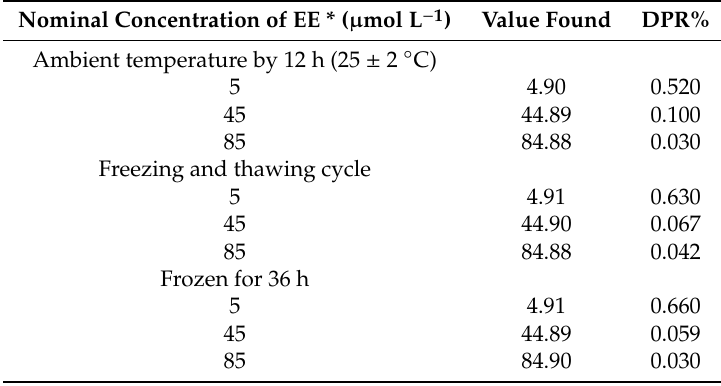
Table 8. Evaluation of the stability of the samples for EE